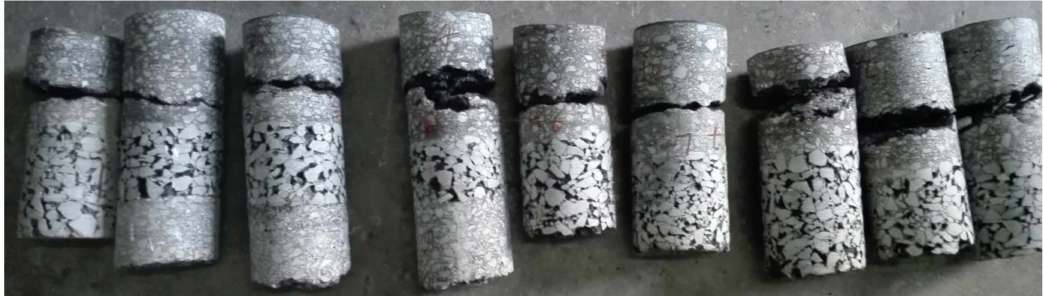
Figure 6. Core samples (the coarse part is the drainage